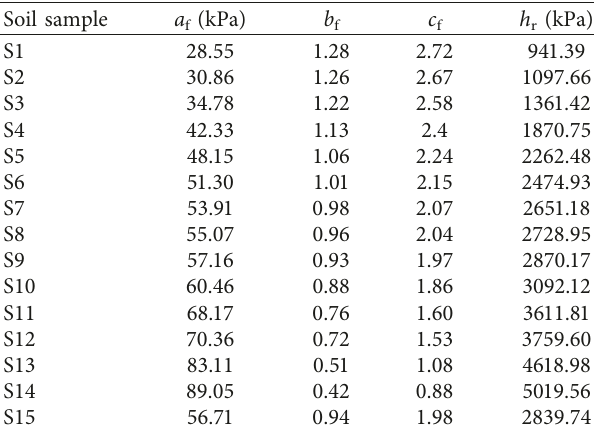
Table 3: Fitting coefficients of Fredlund and Xing’s